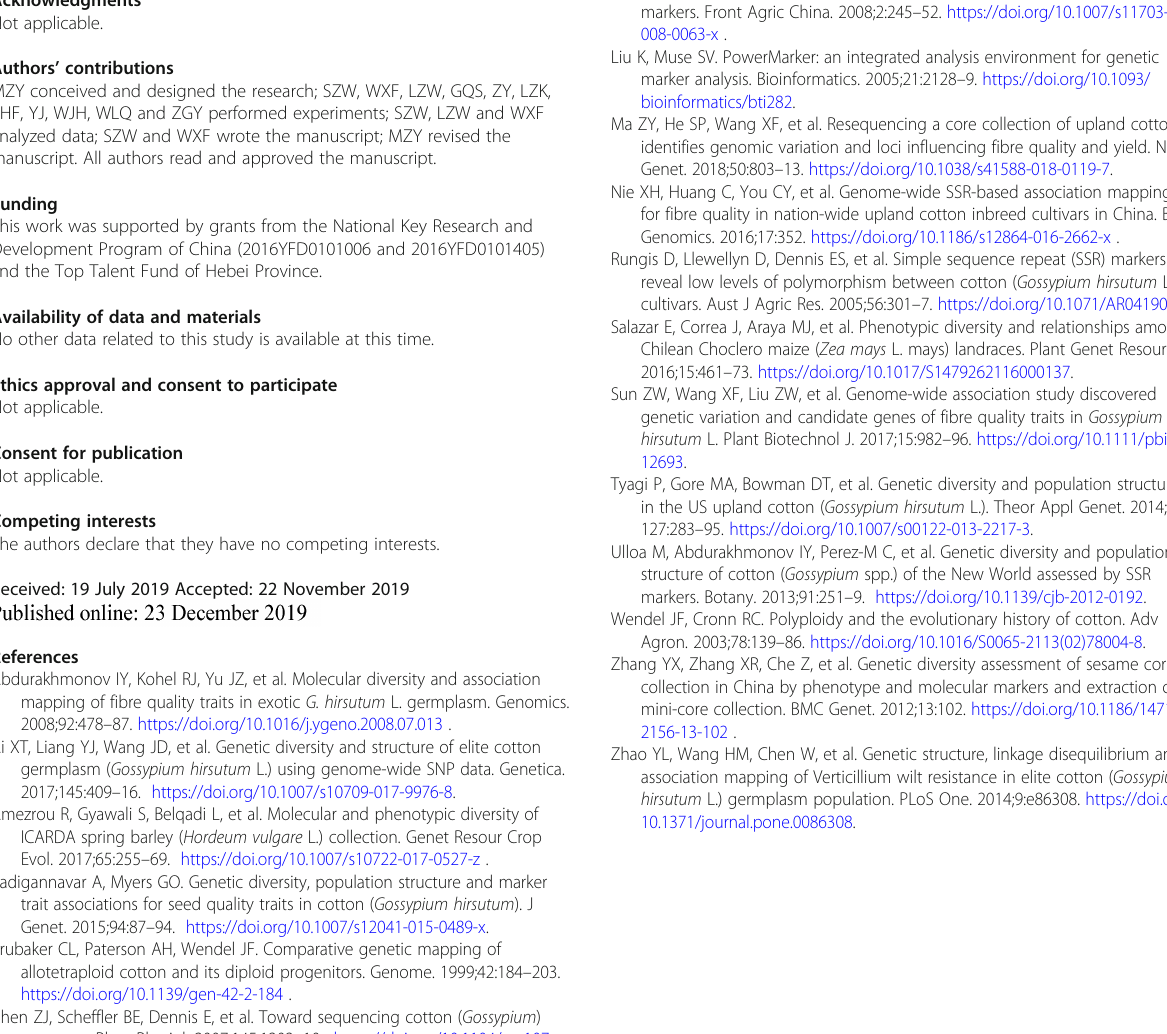
using 719 upland